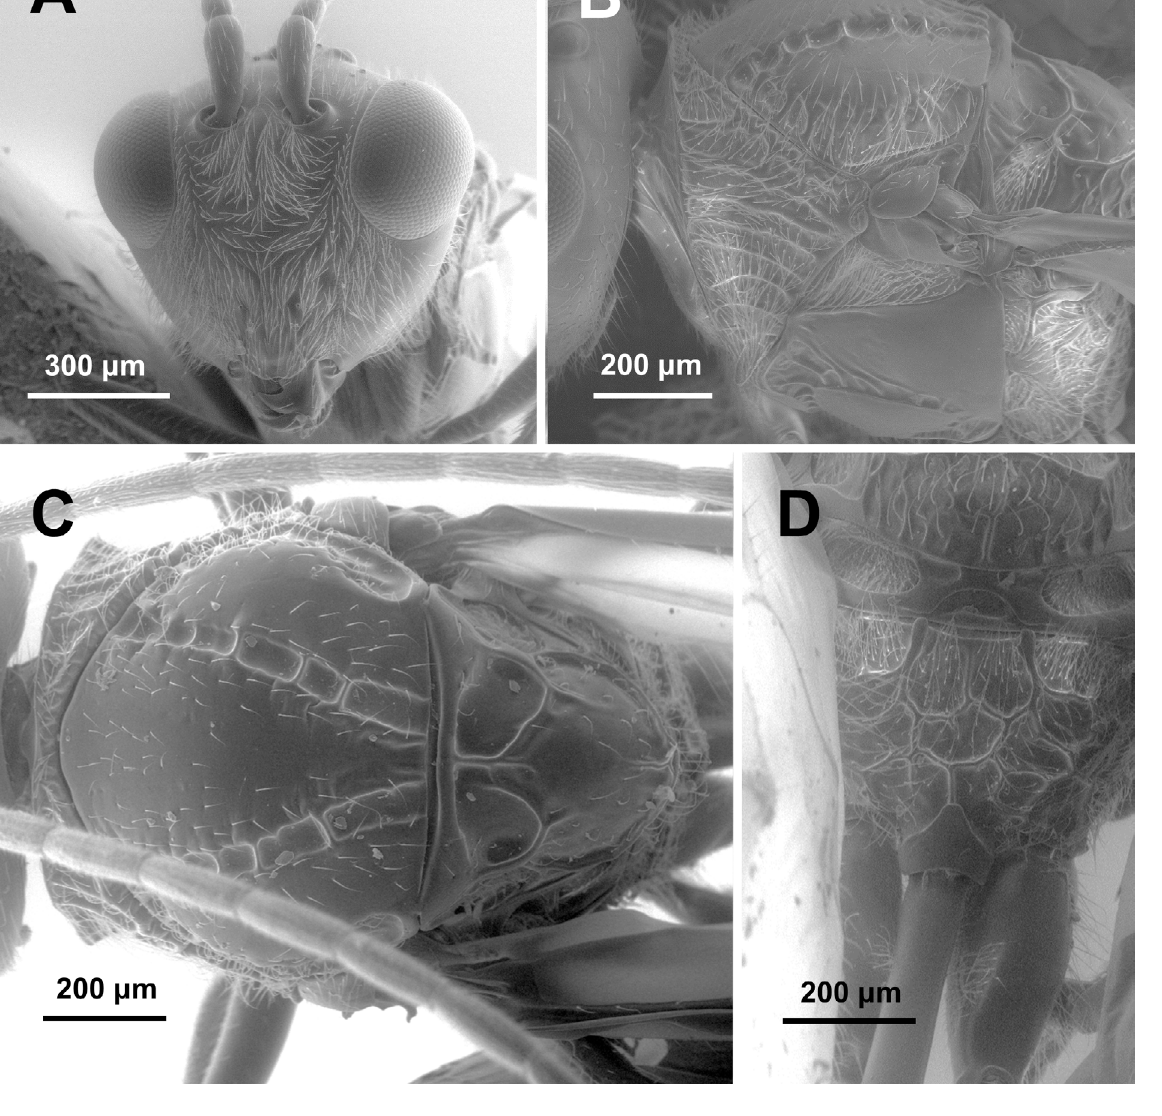
Fig. 3. Anacharis belizini sp. nov. A . Head in front view. B . Mesosoma in lateral view. C . Mesosoma in dorsal view. D .